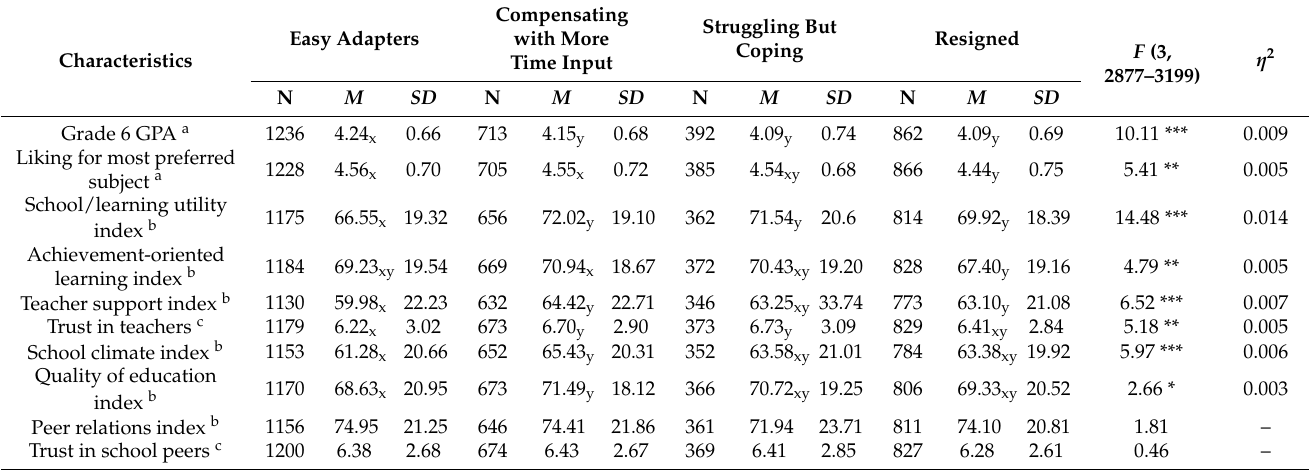
Table 5. Means, standard deviation and one-way ANOVA by school life-related back- ground